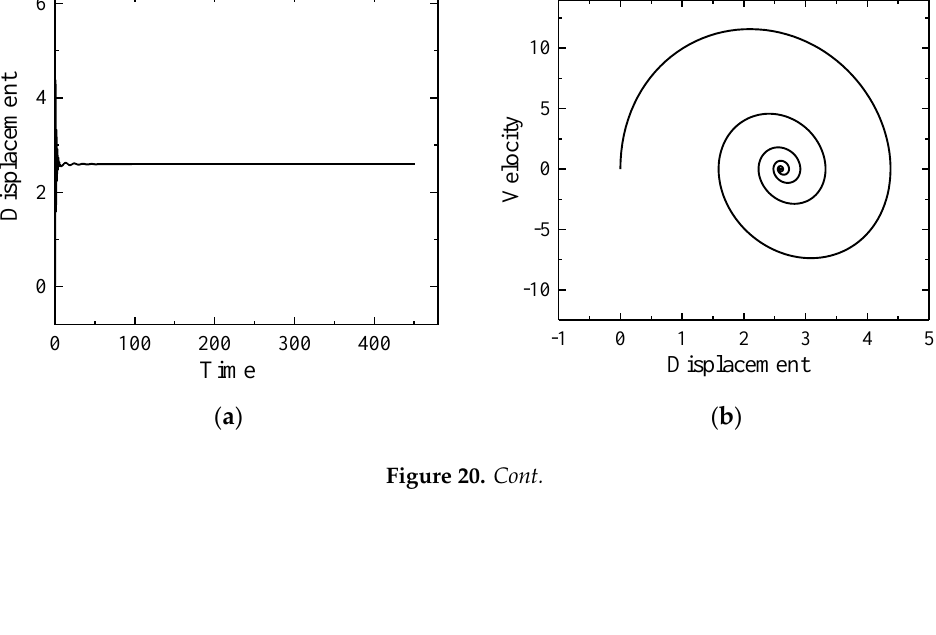
( d ) Figure 20. Evolutions of the displacement and speed-displacement diagram of brake disc and brake shoe at the damping of c1 = 0.1 N∙s/m and c2 = 0.4 N∙s/m. ( a ) Evolution of the displacement of the brake shoe. ( b ) Evolution of the speed-displacement diagram of the brake shoe. ( c ) Evolution of the displacement of the brake disc. ( d ) Evolution of the speed-displacement diagram of the brake disc. (4) Effect of stiffness parameter The simulation parameters are: m 1 = 0.035 kg, m 2 = 2.959 kg, c 1 = 0.1 N∙s/m, c 2 = 0.1 N∙s/m, v 0 = 20 m/s and N = 10 N. In order to explore the effect of stiffness parameter on flutter characteristics between brake disc and brake shoe, the stiffness parameters are k 1 = 0.5 N/m, k 2 = 1 N/m and k 1 = 1 N/m, k 2 = 5 N/m. Figure 21 shows large variation amplitudes of brake disc and brake shoe. An increase in time induces the decrease in the vibration amplitude and then stabilization in both cases. The speed-displacement diagram presents lots of instability limit cycles and then stabilizes for the disc brake. In the case of the brake shoe, the speed-displacement diagram shows several instability limit cycles with a large radius at the start; the vibration amplitude decreases and finally stabilizes to the stability limit point. It is clearly seen from Figures 21 and 22 that an increase in stiffness induces decreases in the vibration amplitude and time reaching stabilization, and increases in the vibration frequency and number of instability limit cycles.